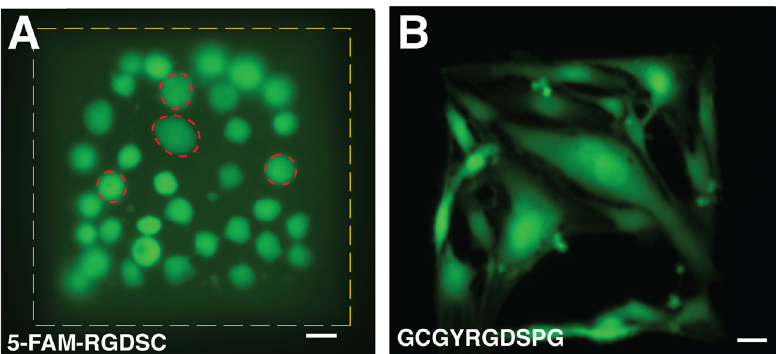
Fig. 7 bEnd.3 morphology on different peptide sequences. A Fluor- escent image (day 7) showing bEnd.3 cells growing selectively on the peptide functionalized area (200 × 200 µm 2 ), marked with a yellow dashed line. The cells remain alive but do not elongate (marked with